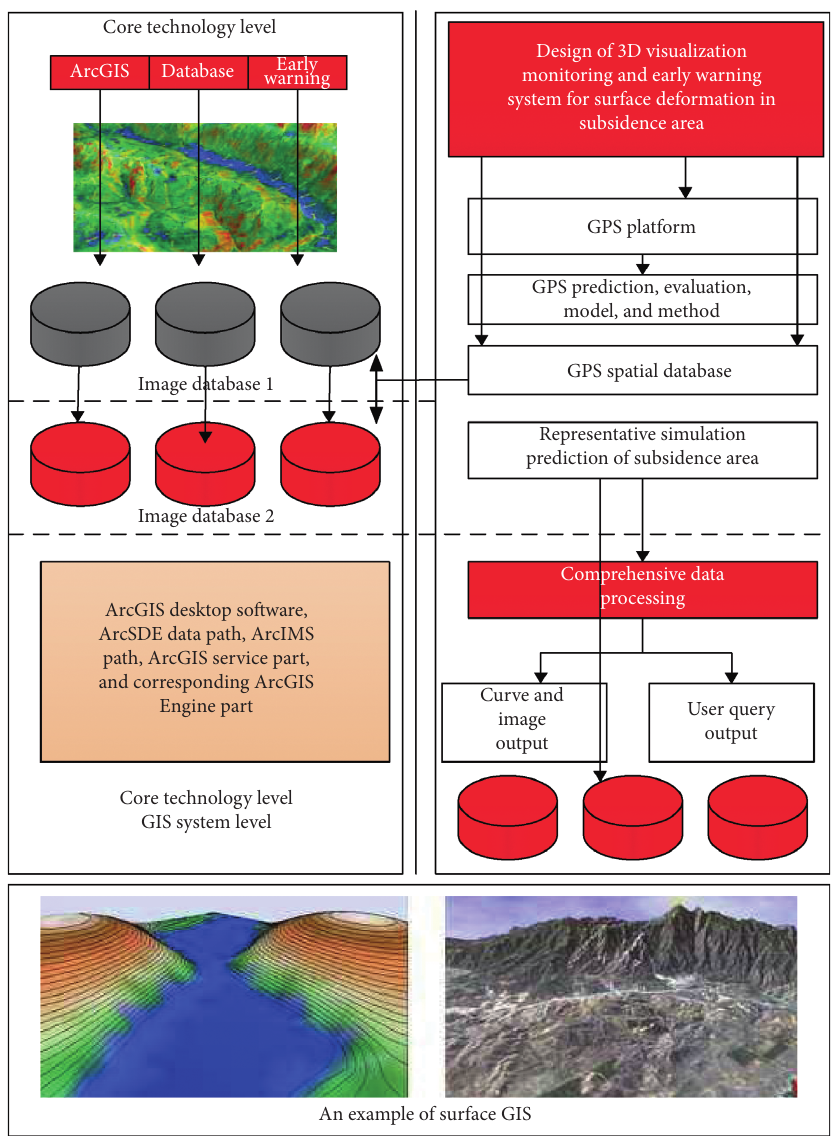
Figure 11: Design of 3D visualization monitoring and early warning system for surface deformation in subsidence